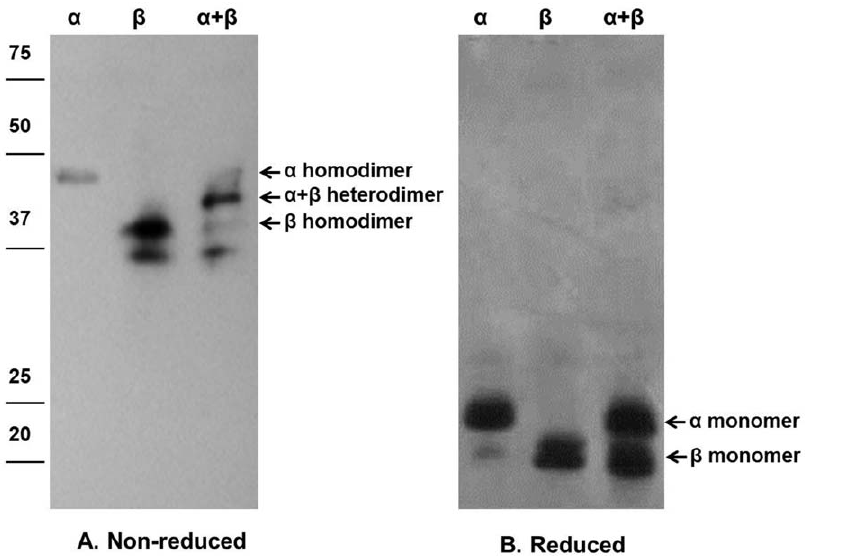
Figure 1. Western blot analysis of r-bursicon proteins in non-reduced (A) and reduced (B) SDS-PAGE identified with an anti-His-Tag antibody. The positions of the r-burs a 2 b heterodimer, burs a 2 a and burs b 2 b homodimers are indicated. Lanes annotated a , b and a + b indicate separate expression of burs a and burs b and co-expression of a + b . The monomers are not present under non-reducing conditions (A). Numbers on far left indicate positions of molecular weight standards.